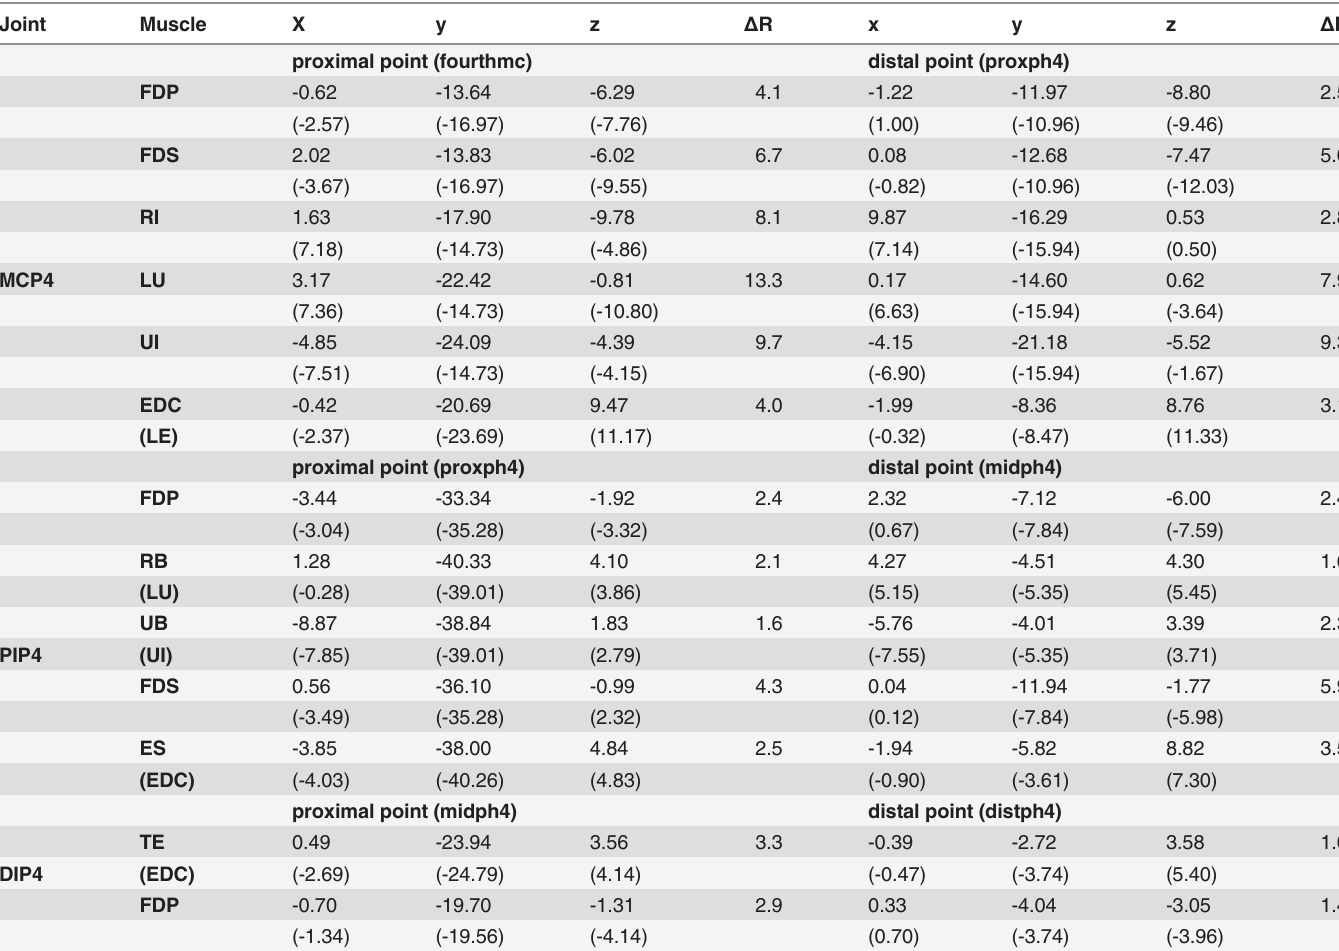
Table 9. Ring finger muscle-tendon locations, expressed in OpenSim frame